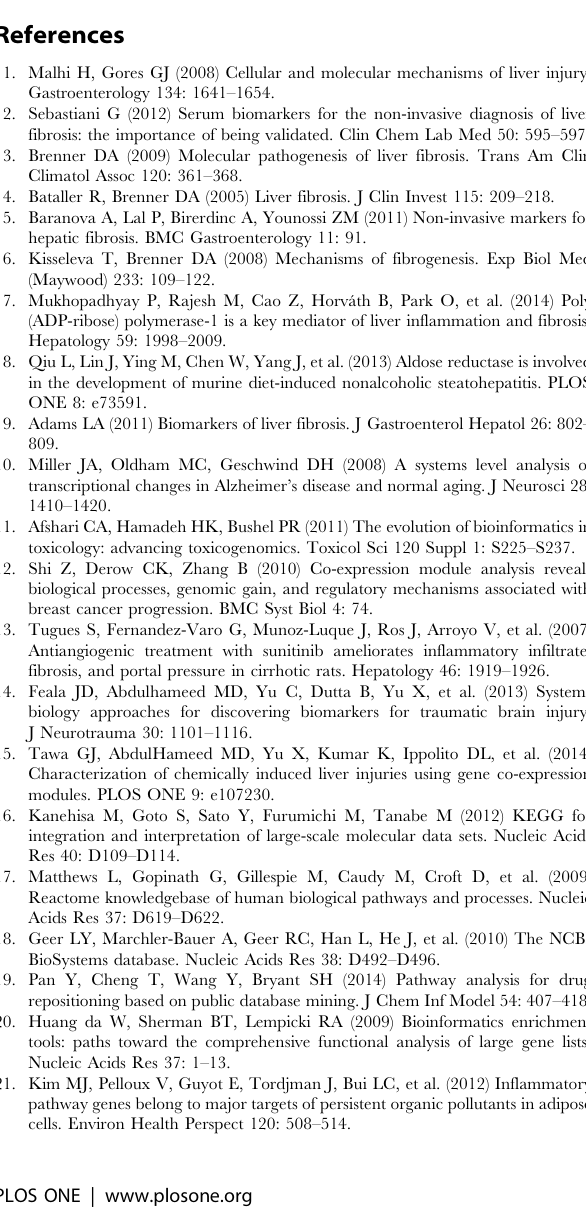
from KeyPathwayMiner, 2) merged nodes of four sub-networks, 3) high-confidence human PPI network data, and 4) the final liver fibrosis-relevant parent